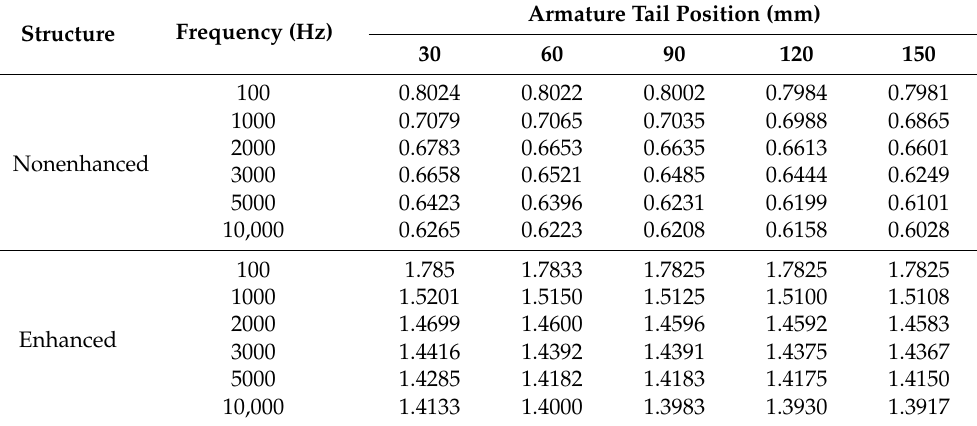
Table 4. Variation in inductance gradient with current frequency and armature position. Unit: ( µ H · m − 1 )